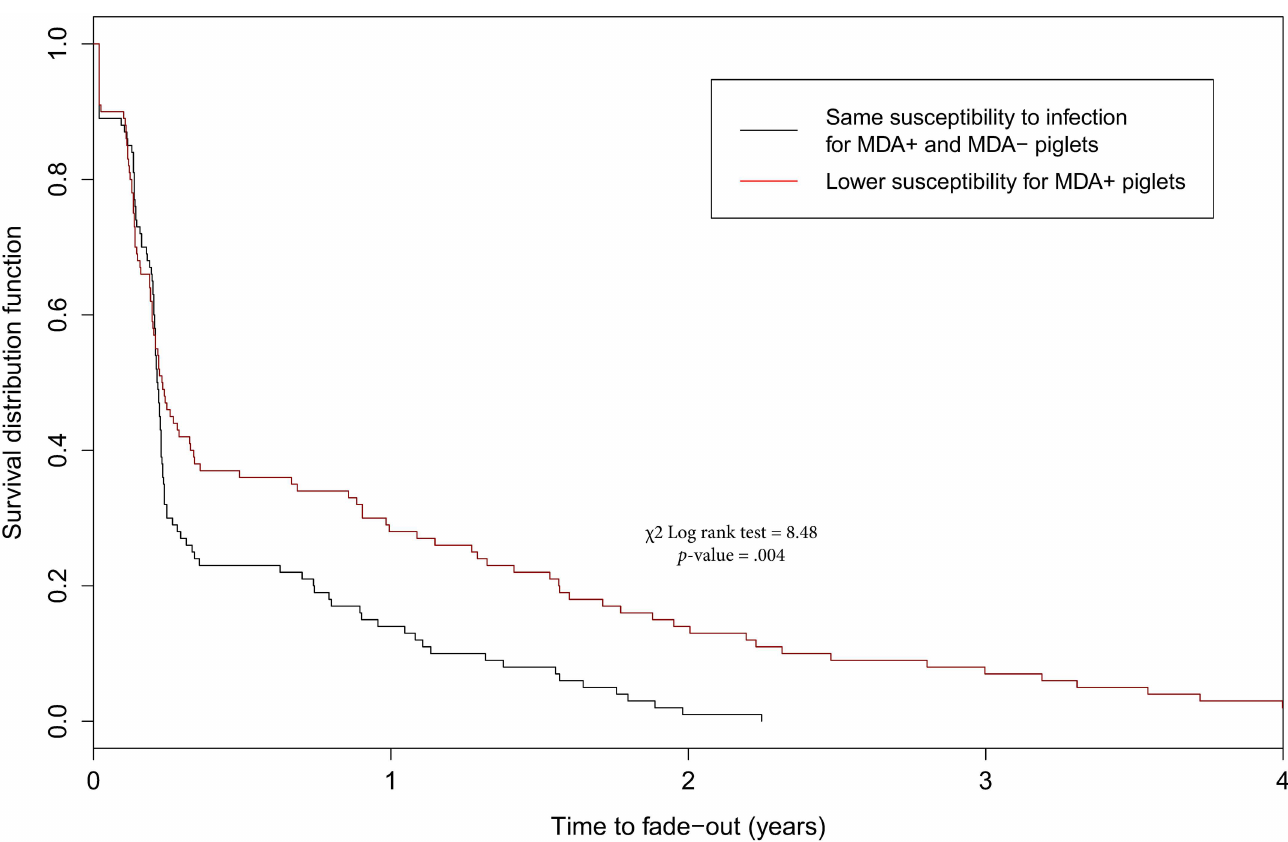
Fig 4. Survival analysis of swIAV within-herd persistence according to the level of susceptibility to infection for MDA-positive piglets. 100 simulations per scenario, χ 2 Log rank test = 8.48, p -value =